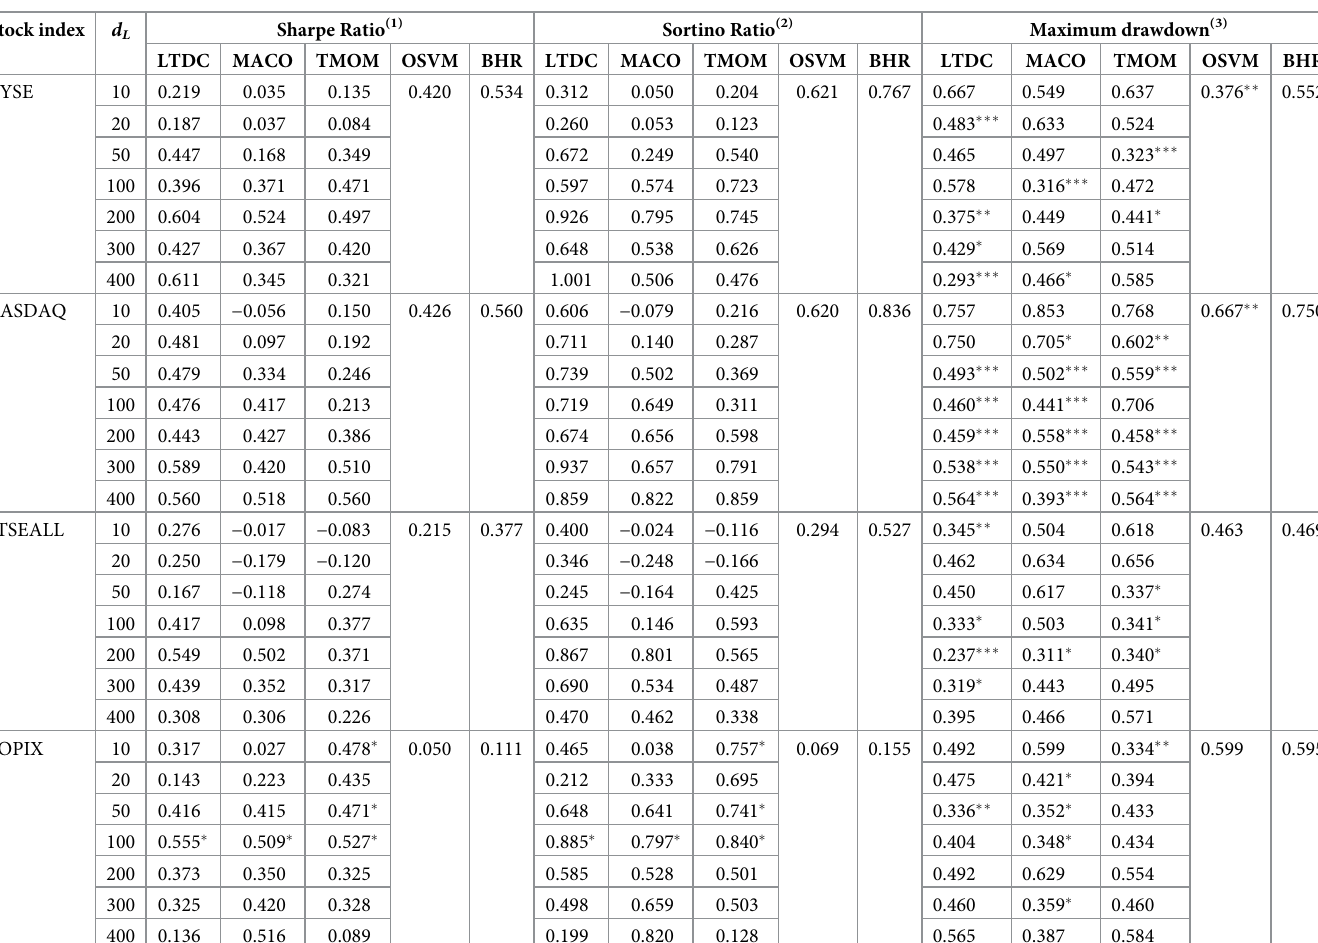
Table 2. Risk tolerance